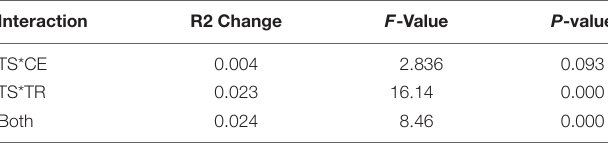
TABLE 7 | 5000 Bootstrap results for PROCESS Model No.2, test for higher-order unconditional interactions. Interaction R2 Change F -Value P -value TS*CE 0.004 2 . 836 Both 0.024 8 . 46 0.000